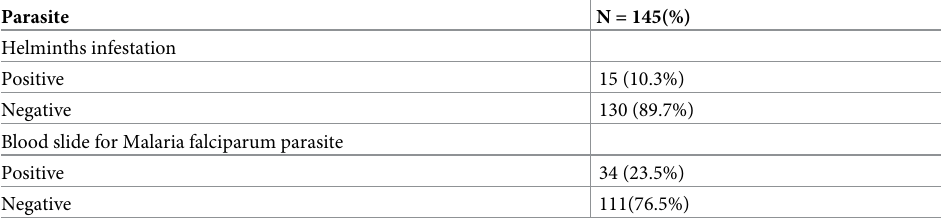
Table 4. Helminthiasis and Malaria falciparum parasitisation among anemic women attending primary public health centers in Dar es Salaam (n = 145).